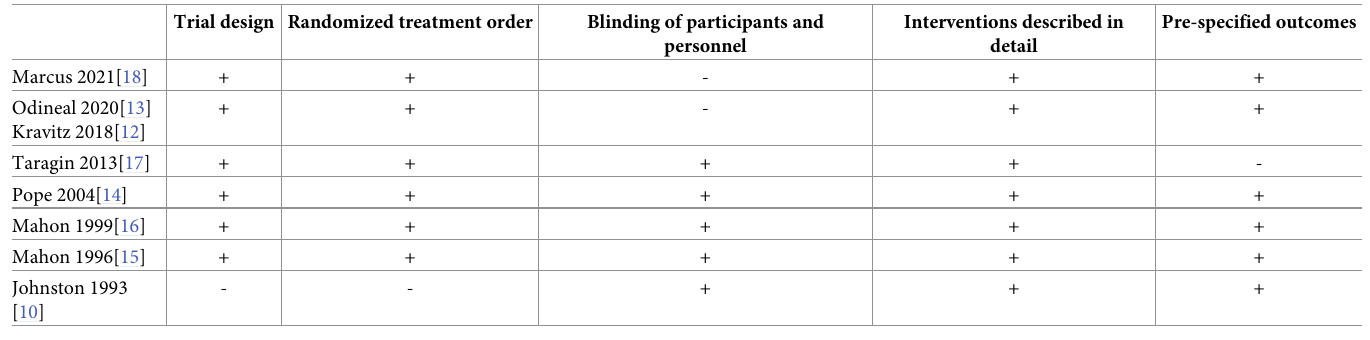
Table 2. Risk of bias of n-of-1 trial design. Trial design Randomized treatment